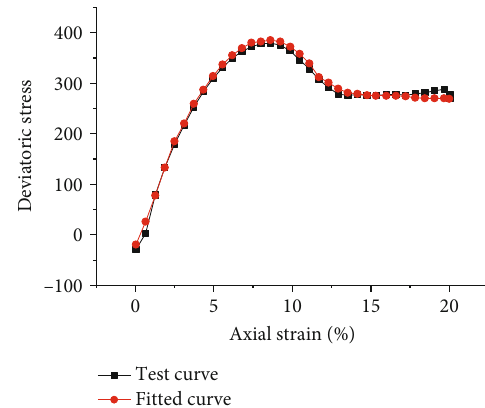
Figure 5: Comparison of theoretical and experimental